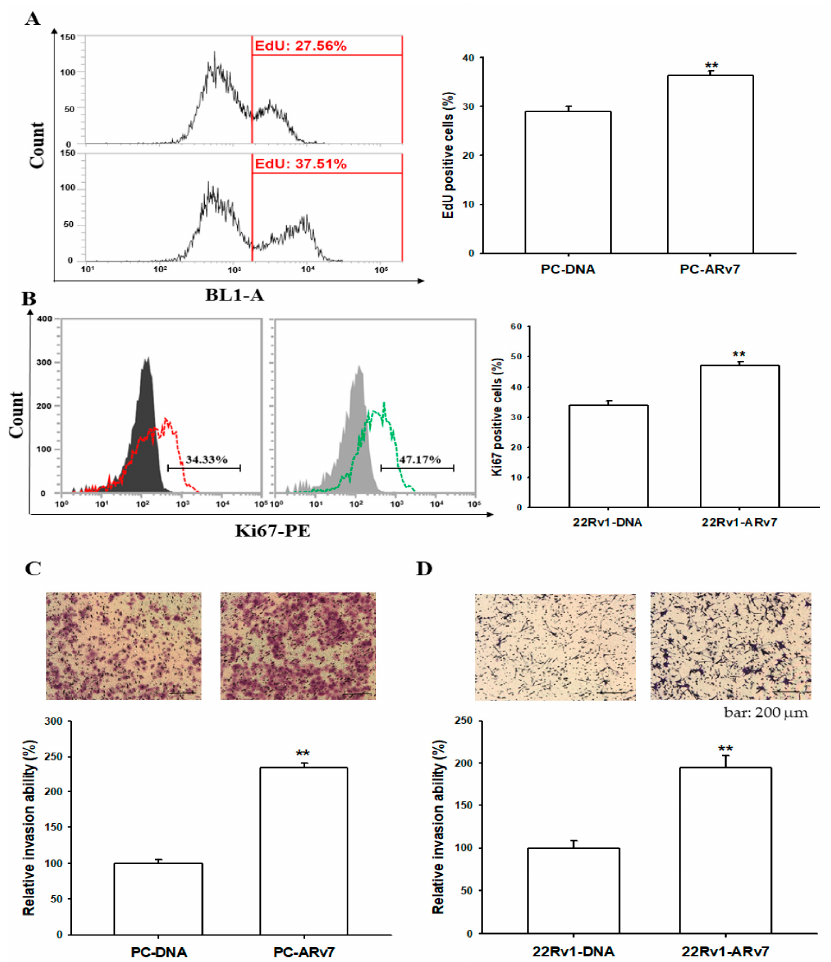
Figure 6. Effects of ectopic-overexpressed ARv7 on cell proliferation and invasion in PC-3 and 22Rv1 cells. ( A ) The proliferation ability of PC-DNA and PC-ARv7 cells was determined through fl ow cytometry using the Click-iT EdU fl ow cytometry kit (±SE, n = 4). ( B ) The proliferation ability of 22Rv1-DNA and 22Rv1-ARv7 cells was determined through fl ow cytometry using the Ki67 fl ow cytometry kit (±SE, n = 4). The invasion ability of PC-3 ( C ) and 22Rv1 ( D ) cells after stable transfection with the mock vector or ARv7 expression vector was determined through in vitro Matrigel invasion assays (±SE, n = 3). The bar line represents 200 µm. ** p < 0.01.